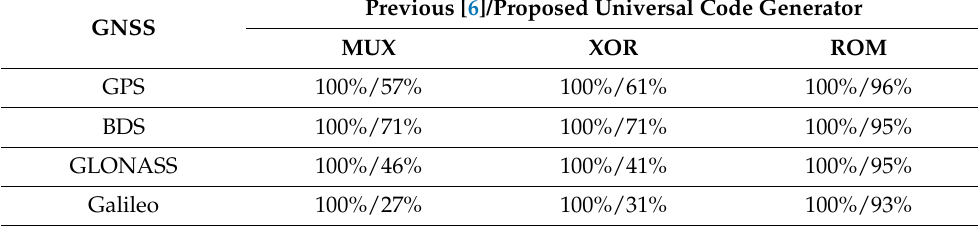
Table 6. Comparison of normalized hardware resource use of previous code generator and proposed code